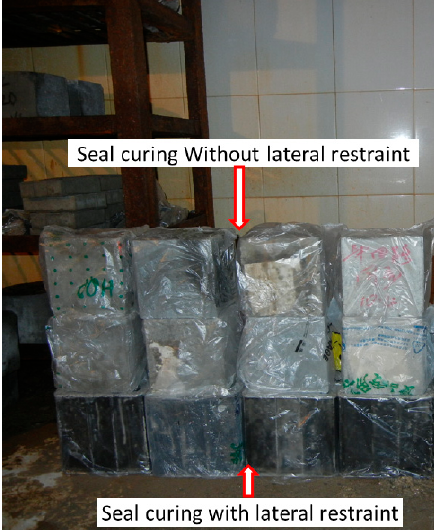
Figure 6. Concrete test specimens with different lateral restraints.